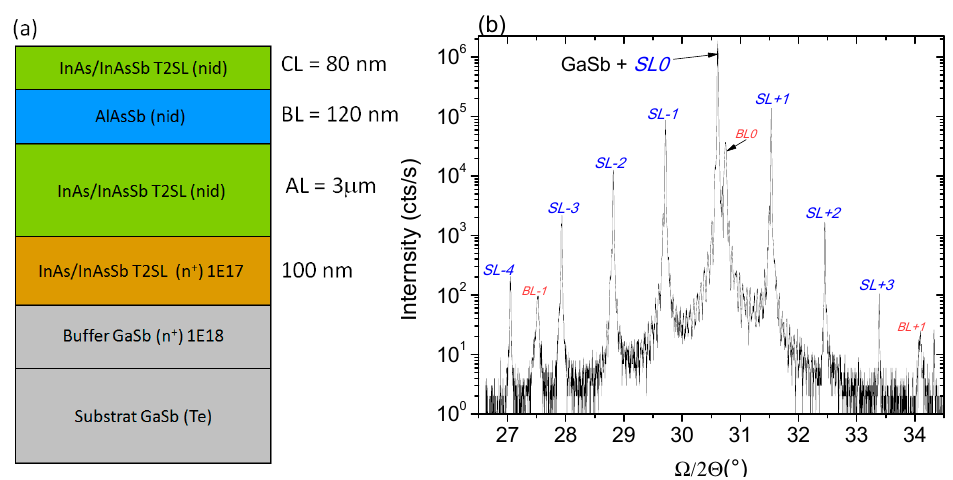
Figure 1. ( a ) Stacking of the XBn InAs/InAsSb T2SL structure grown by MBE on GaSb substrate. ( b ) HR-XRD pattern of the T2SL detector structure. The lattice mismatch with the GaSb substrate is -354 ppm.